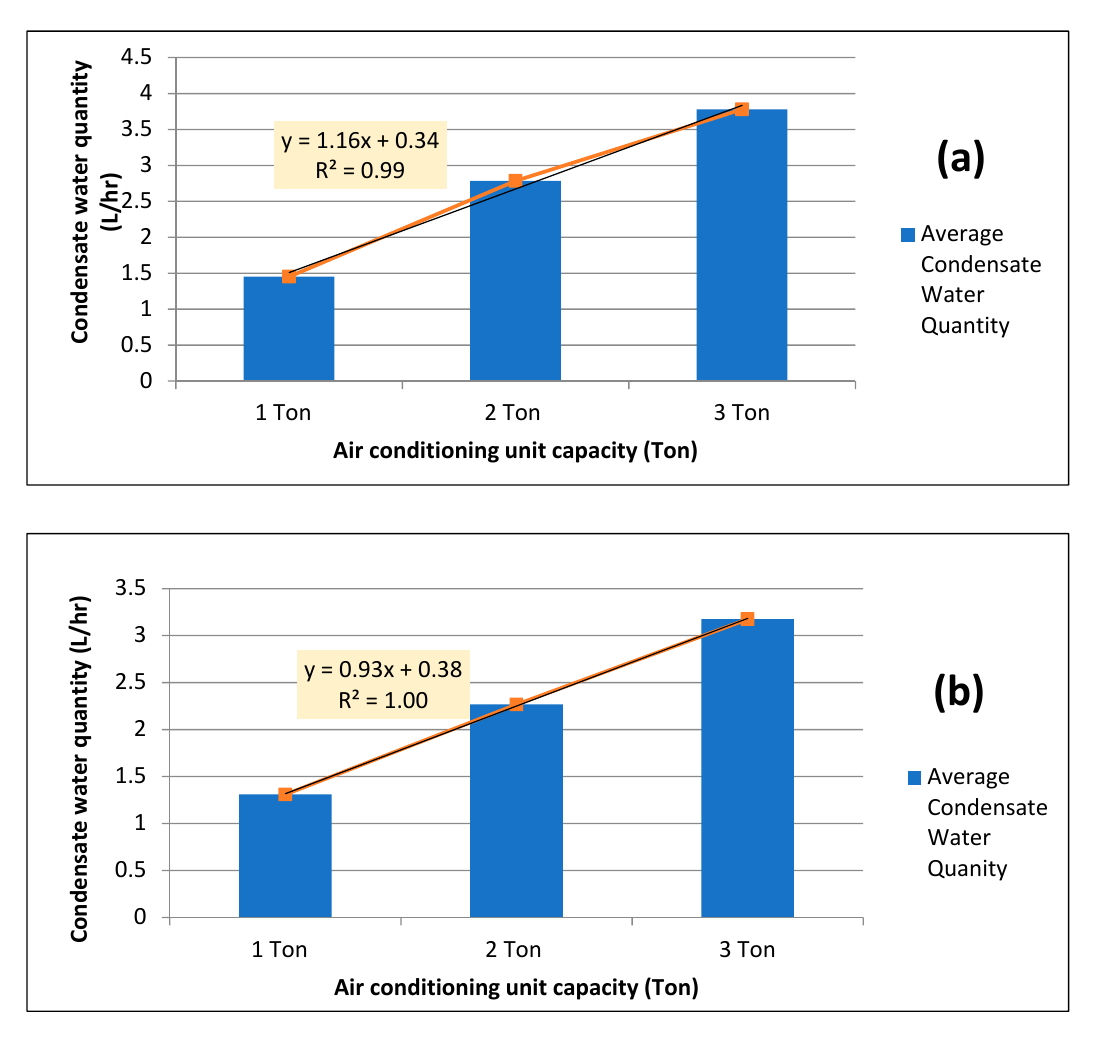
Figure 3. Quantities of condensate water in Ramallah city at: ( a ) 16 °C operating temperature and ( b ) 18 °C operating temperature.